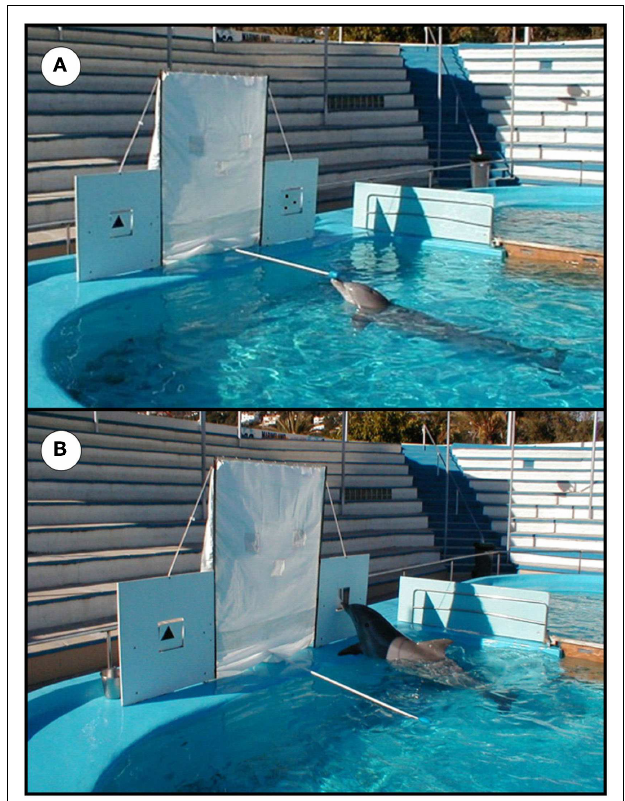
FIGURE 1 | (A) Overview of the testing situation with the apparatus, the stationing device, and the position of the dolphin facing the revealed stimuli; (B) Blue touching one of the displayed stimuli with his